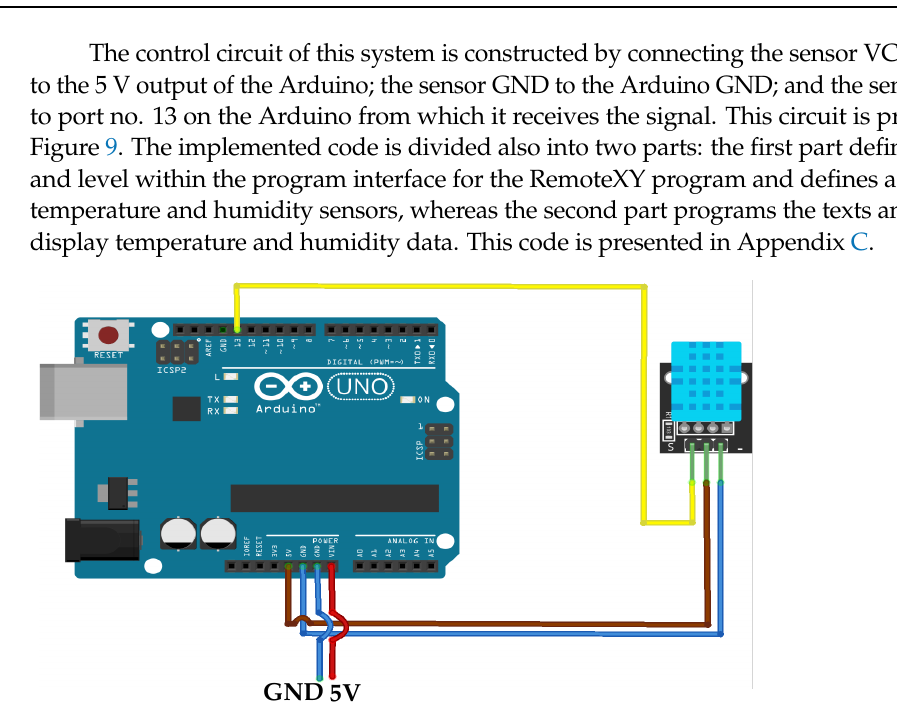
Figure 10. The graphical user interface on the phone for controlling the fire alarm system in the smart home.